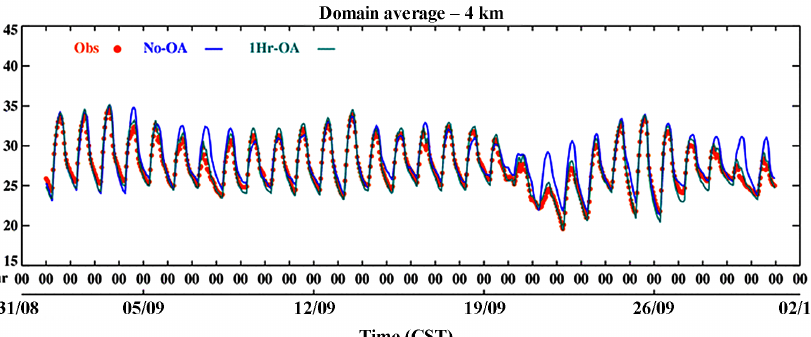
Figure 3. Regional hourly temperature averaged over all available hourly CAMS observations; two model cases are also included for Septem- ber of